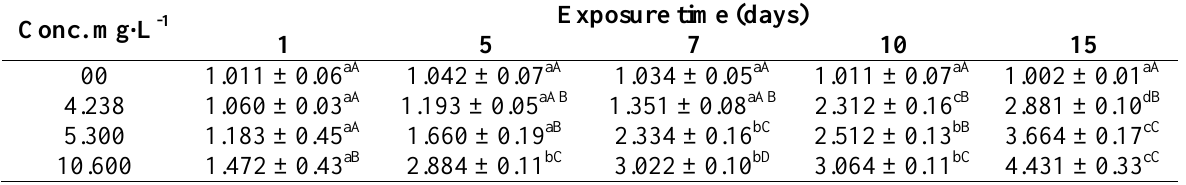
Table 4. Formation of thiobarbituric acid reactive substances (TBARS) (nmol/mg protein) in liver of C. punctatus exposed to sublethal doses of atrazine for 1–15 days . Conc. mg · L -1